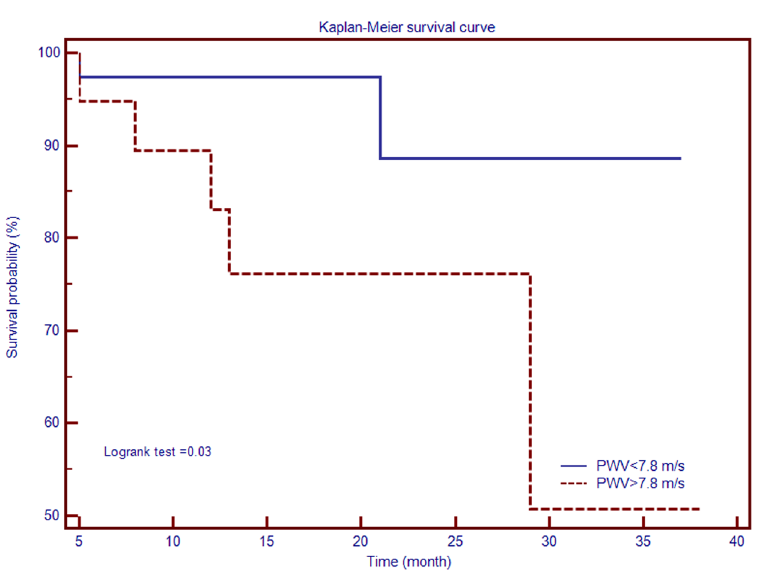
Figure 3. Kaplan–Meier curves yielding the value of pulsed wave velocity for predicting event-free survival in patients with secondary pulmonary hypertension due to chronic obstructive pulmonary